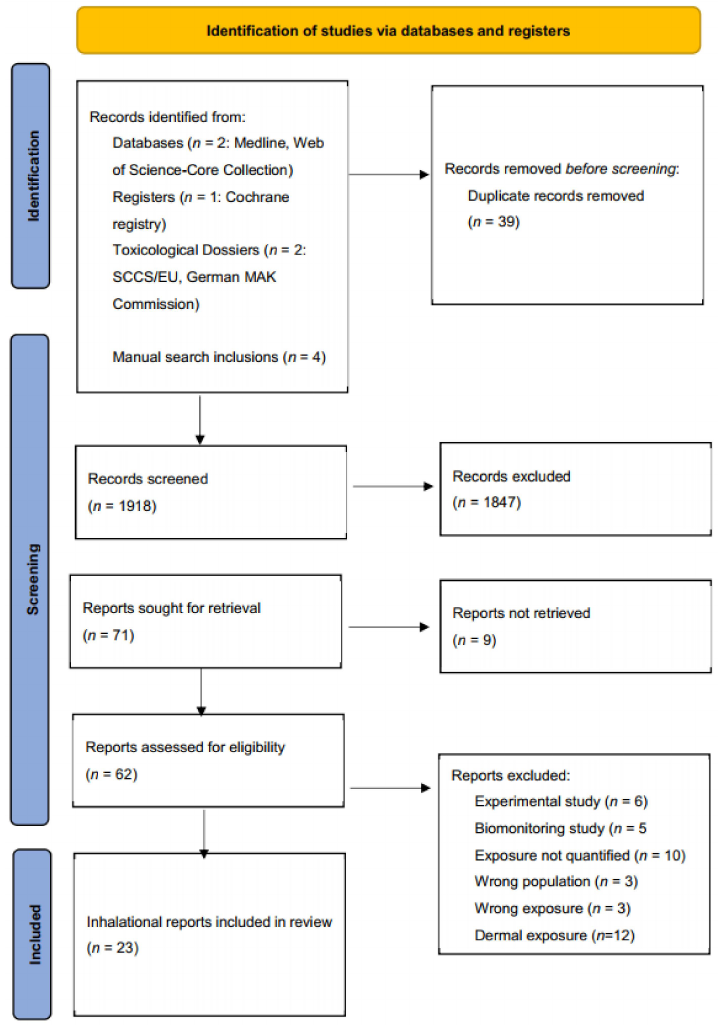
Figure 1. PRISMA Flow diagram for the screening and selection of